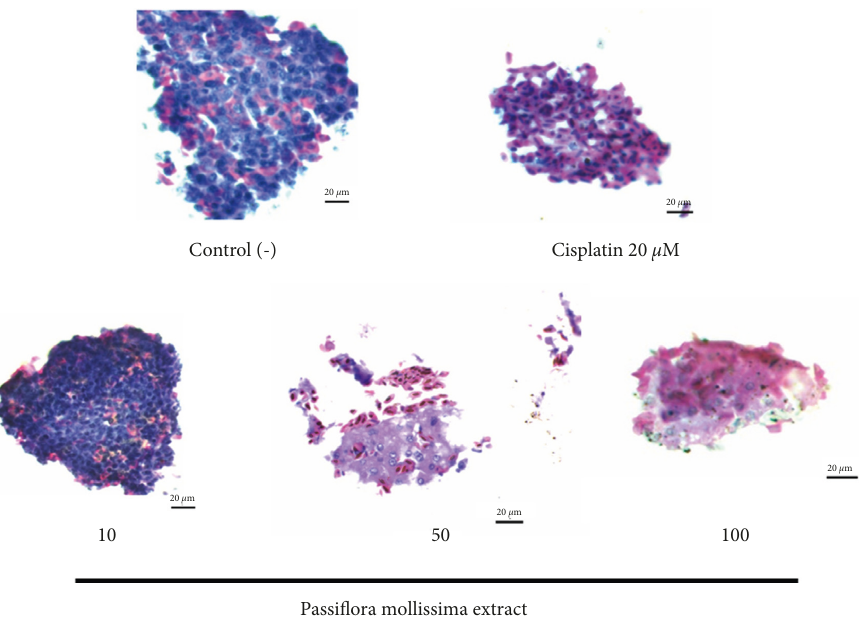
Figure 4: Histological changes of spheroid with H&E staining. It was shown the effect of PME (10, 50, and 100 μ g/ml) and 20 μ M of cisplatin drug at 72hours on spheroid morphology. Viable cells with high proliferation and high DNA concentration are dark pink, and necrotic cells show light pink. Scale bar: 20 μ m.